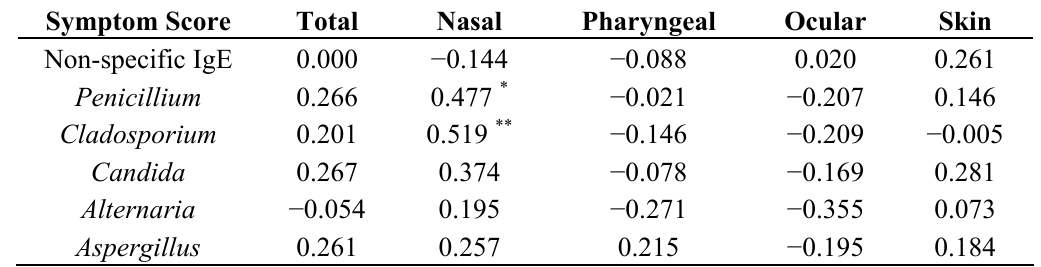
Table 1. Spearman rank-correlation coefficients between symptom scores and IgE serum